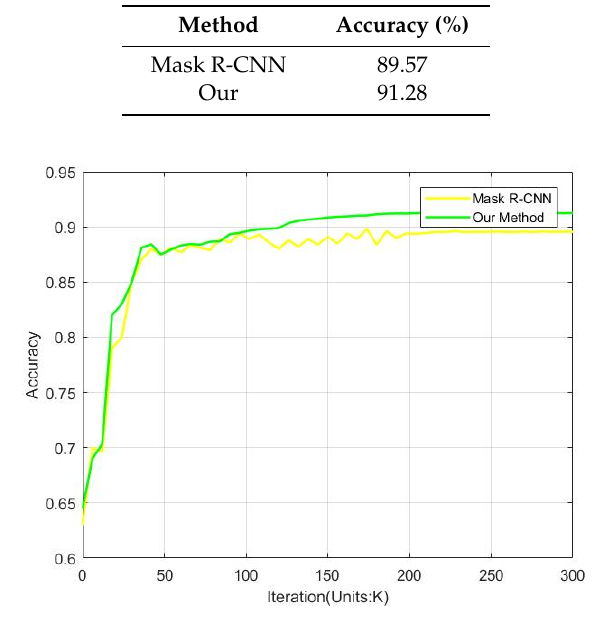
Figure 7. Mask R-CNN and our method’s target region border average accuracy. Table 2. Target area border average accuracy.